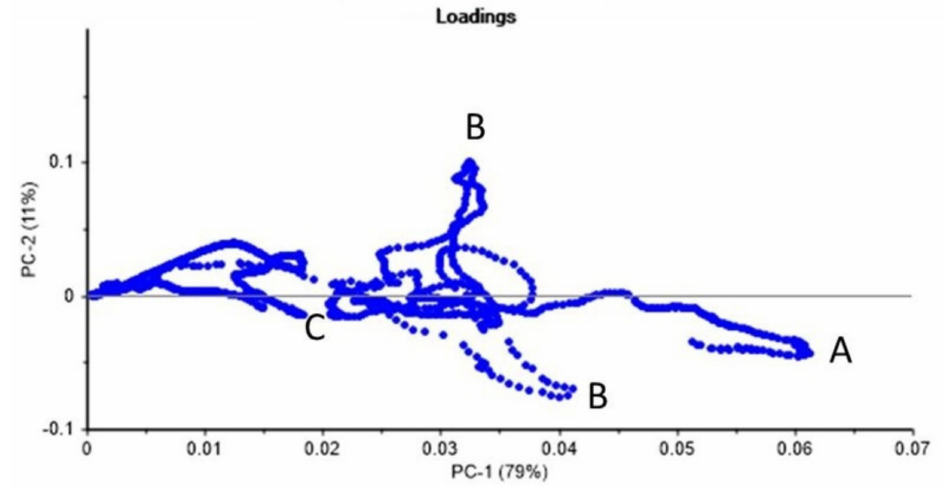
Figure 5. PCA loading ATR-FTIR spectral ranges (A, B, C) for C. arietinum root samples grown at three conditions (Class). See text and Table 1 for more details.